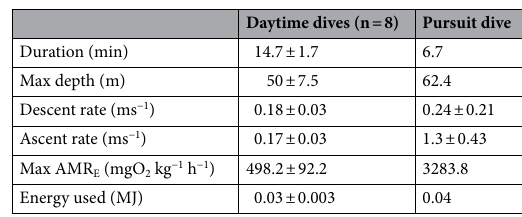
Table 1. Summary statistics for dives performed by the sailfish during daylight hours compared to the dive in which the predation event took place. Values are presented as mean ± SD where